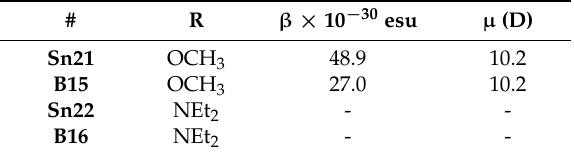
Table 4. Second-order NLO properties for the diorganotin and diorganoborate compounds.